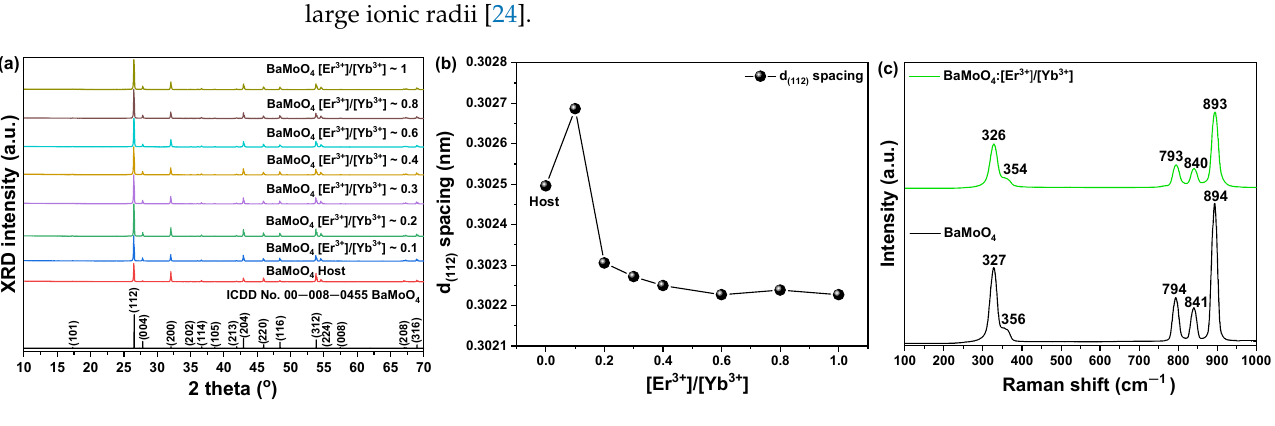
Figure 2. ( a ) XRD patterns of synthesized BaMoO 4 and BaMoO 4 :[Er 3+ ]/[Yb 3+ ] powders, and ( b ) change in d (112) spacing and ( c ) Raman spectra of BaMoO 4 (black line) and BaMoO 4 :[Er 3+ ]/[Yb 3+ ] (green line) under 532 nm laser.